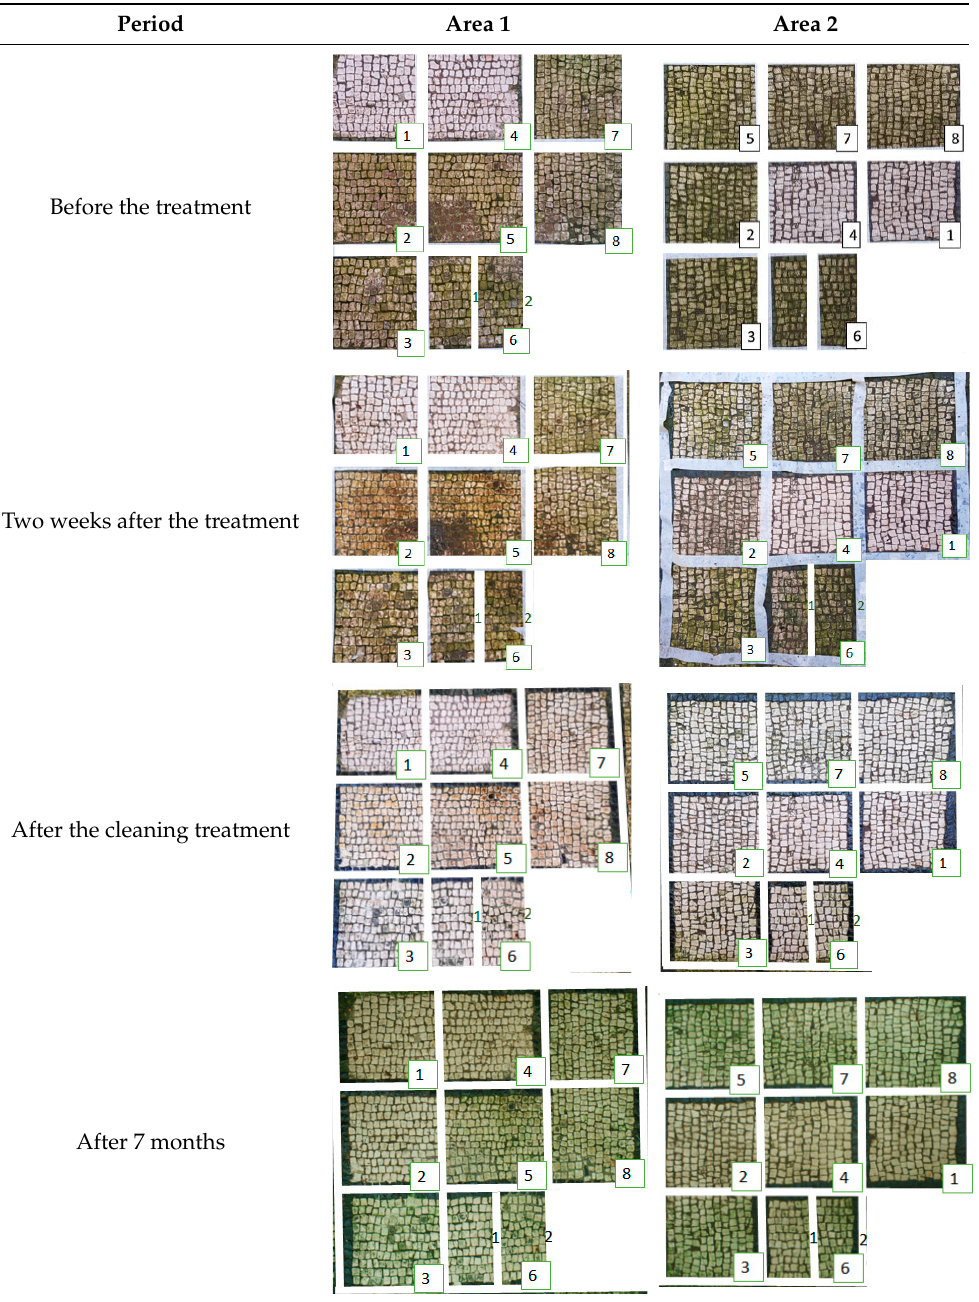
Table 4. VIS Images of Areas 1 and 2 before the biocide treatments, two weeks after the application and 1 month after the cleaning procedure. Legend of the figures in the table: (1) Preventol ® RI50 (cleaned area), (2) Preventol ® RI50, (3) Essenzio, (4) SI-QUAT, (5) Bionature, (6_1) AUTEAB supported, (6_2) AUTEAB washed, (7) LIQ, and (8) Biotersus.